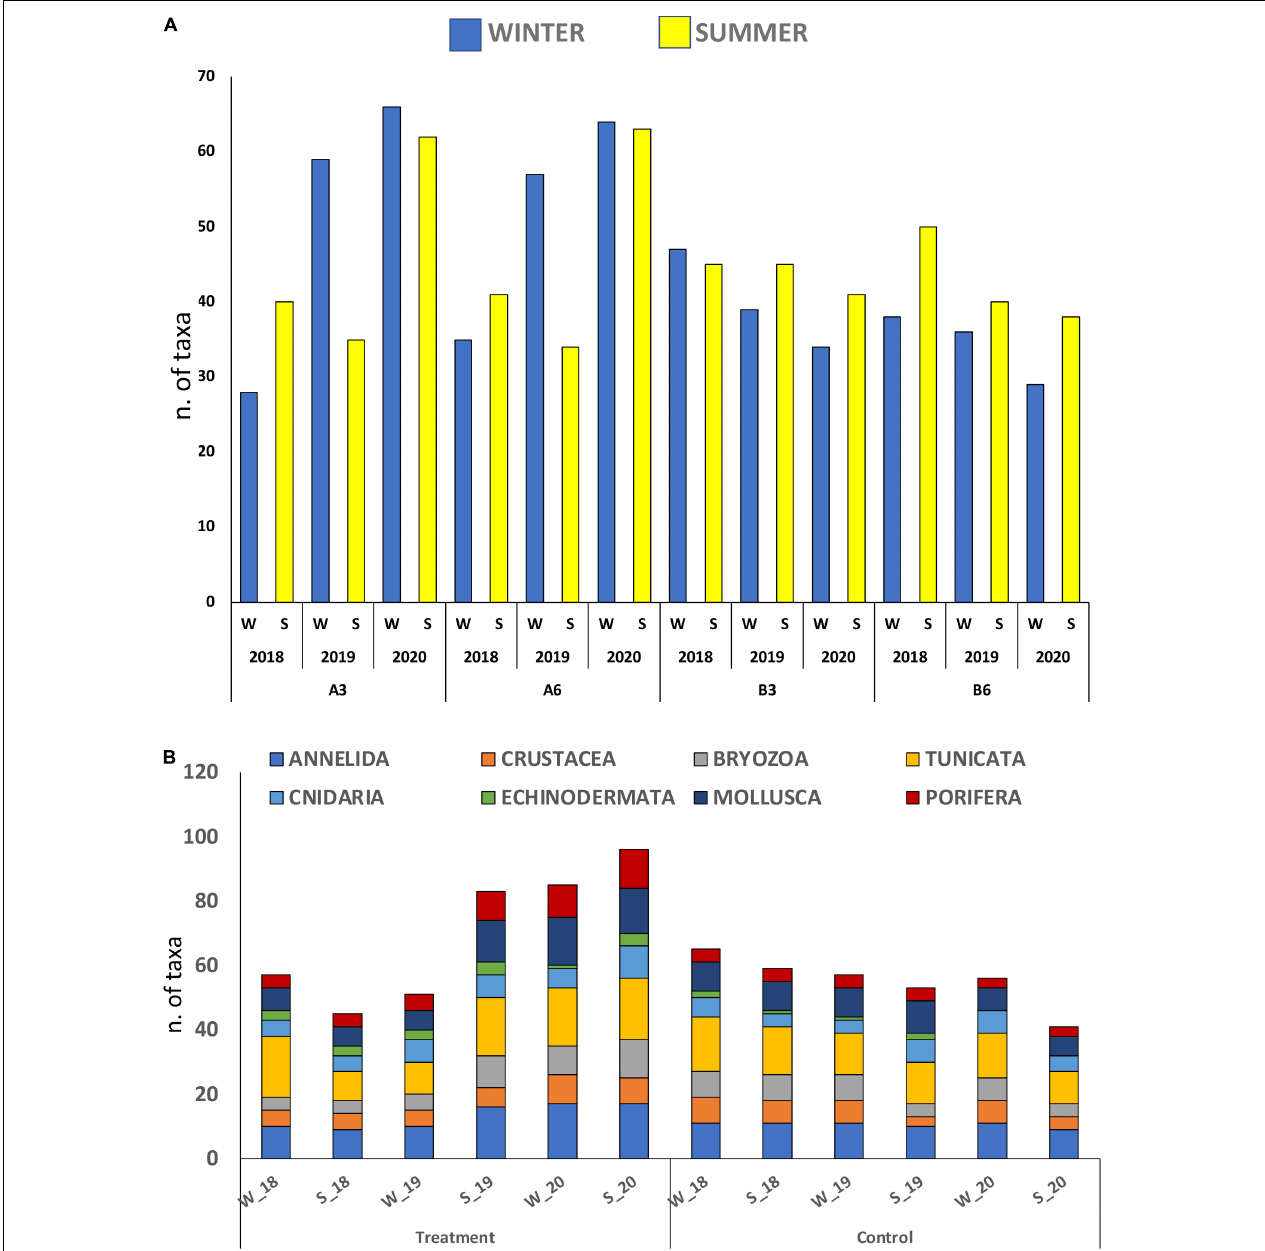
FIGURE 4 | The trend in macrobenthic taxa detected during the 3 years of study on the hard substrates under the fish cages in the treatment (A3 and A6) and control (B3 and B6) sampling points (A) and its composition (B) . W = winter; S =